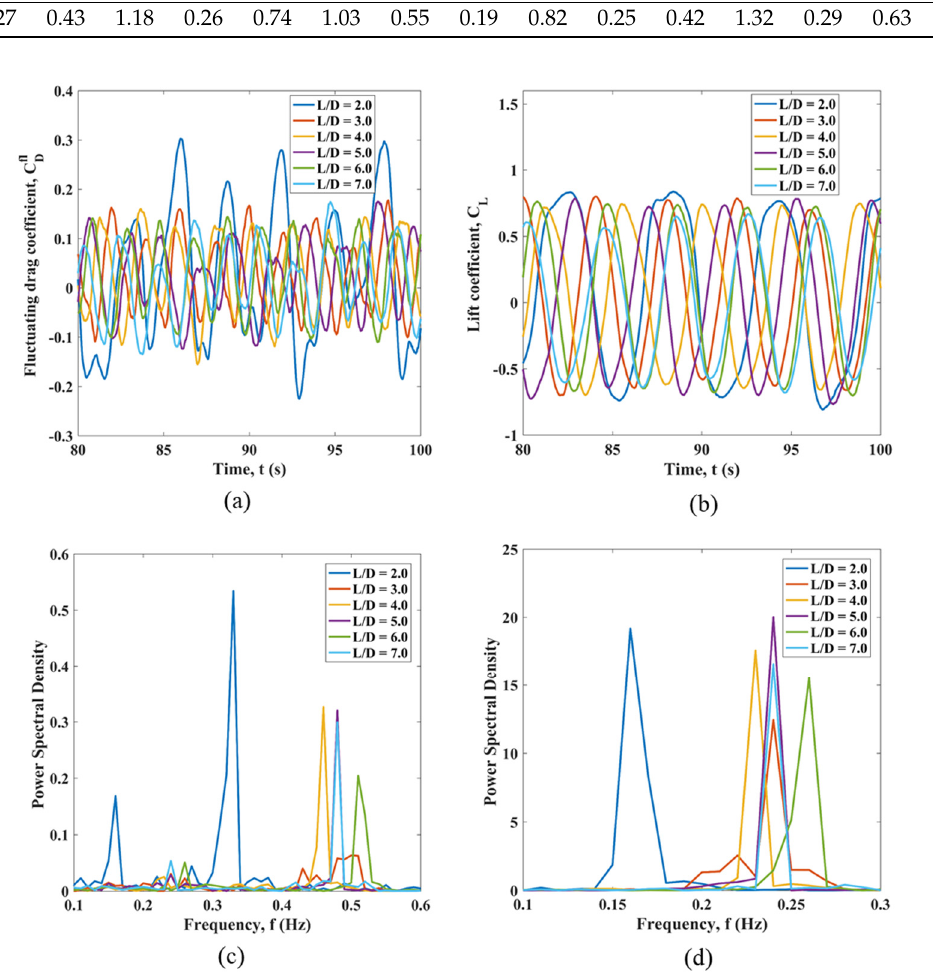
Figure 2. Fluid force coefficients for cylinder 1 immersed in the uniform flow: ( a ) time history of the fluctuating drag coefficient; ( b ) time history of the lift coefficient; ( c ) the fluctuating drag coefficient FFT; ( d ) the lift coefficient